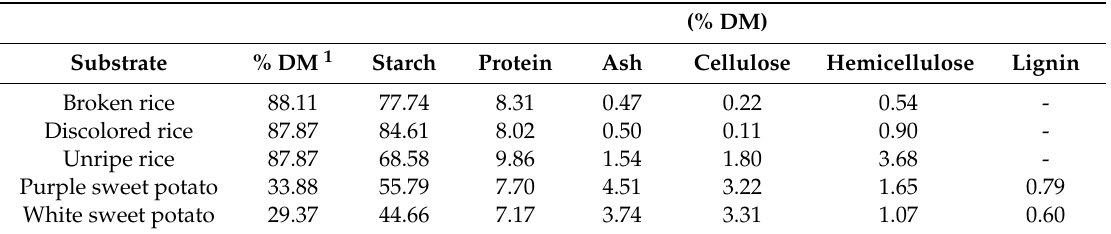
Table 1. Chemical composition of rice and sweet potato waste streams used in this study.